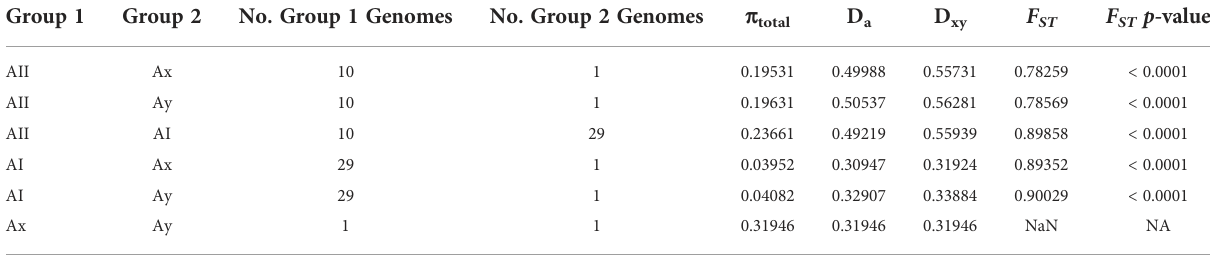
TABLE 2 Pairwise estimate of genetic diversity and divergence between lineages across silent sites. Group 1 Group 2